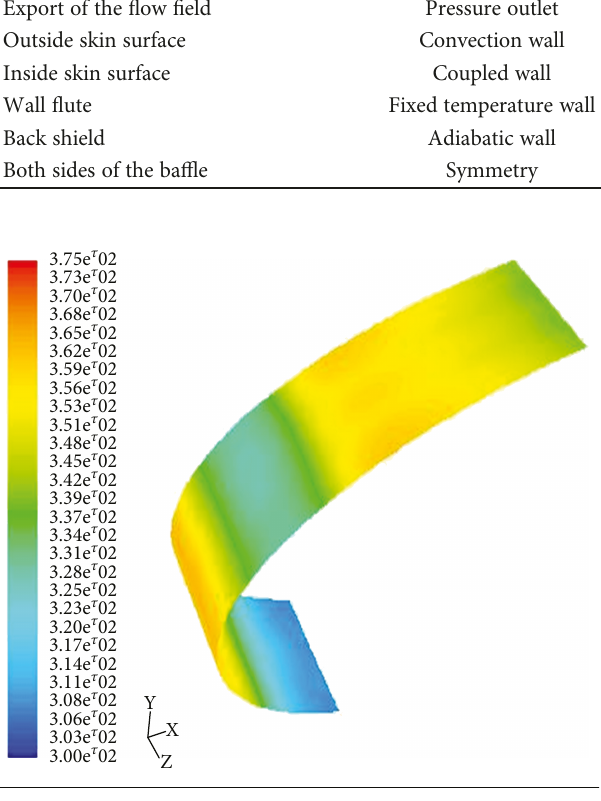
Figure 4: Temperature nephogram of the wing skin surface.